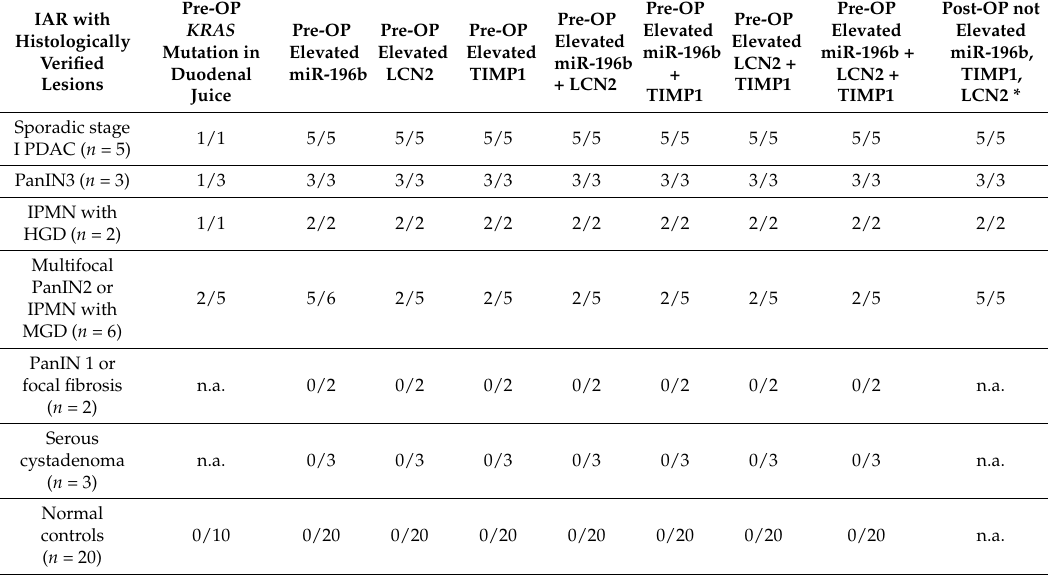
Table 5. Detailed biomarker results in IAR with histologically defined pancreatic lesions ( n = 16) compared to stage I PDAC and